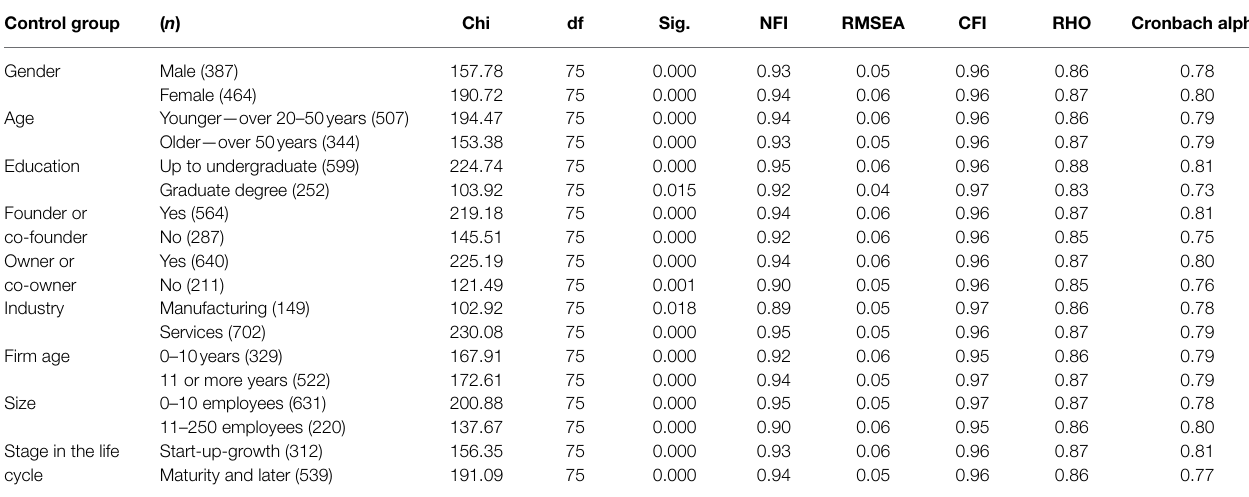
TABLE 9 | Structural equation modeling results—controls (goodness-of-fit and reliability). Control